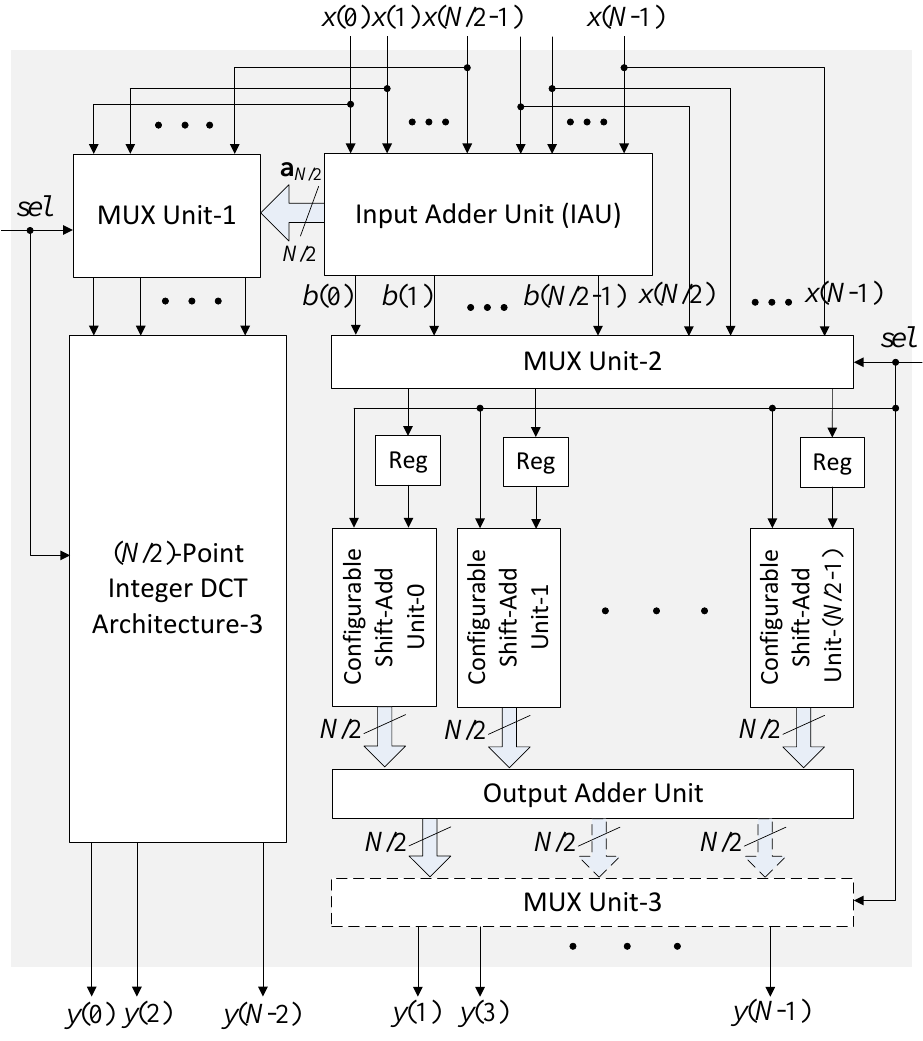
Figure 3. Proposed Architecture-3 for N = 8, 16, and 32. The number of output samples of the output adder unit (OAU) is N /2, N , and 3 N /2 for N = 8, 16, and 32, respectively. The four-point integer DCT architecture is the same as the one shown in Figure